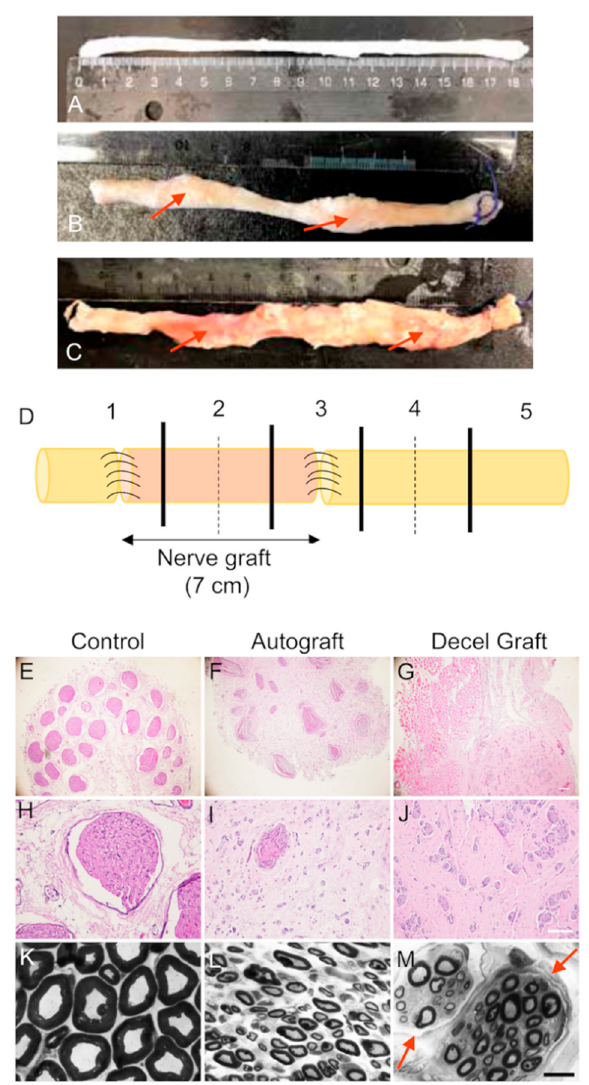
Figure 6. Macroscopic representative pictures of a control sheep peroneal nerve ( A ), a peroneal nerve autograft ( B ), and a decellularized nerve allograft ( C ), both with a neuroma visible (marked with red arrows) at proximal and distal sutures, harvested at the end of the study. ( D ) Schema of the division in sections of nerves harvested. Section 1 includes the proximal suture and Section 3 includes the distal suture of the graft. Sections 2 and 4 were divided into two different segments (dotted line). Micrographs of cross sections of the proximal segment of the graft of sheep stained with hematoxylin and eosin. ( E , H ) control nerve, ( F , I ) autograft and ( G , J ) decellularized nerve graft; E , F , G scale bar 200 µ m, and H , I , J scale bar 100 µ m. Representative semithin transverse sections of the graft of sheep in AG and DC groups, stained with toluidine blue. ( K ) control nerve, ( L ) autograft and ( M ) decellularized nerve graft, scale bar 10 µ m. Red arrows in M point to the newly formed regenerative small